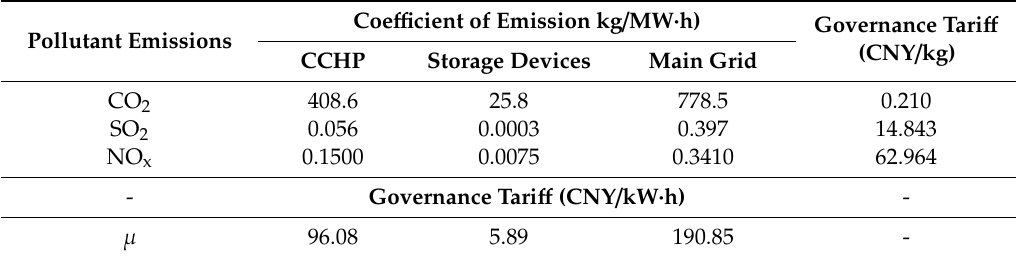
Table 2. Pollutant emissions coefficient and environmental governance tariff.